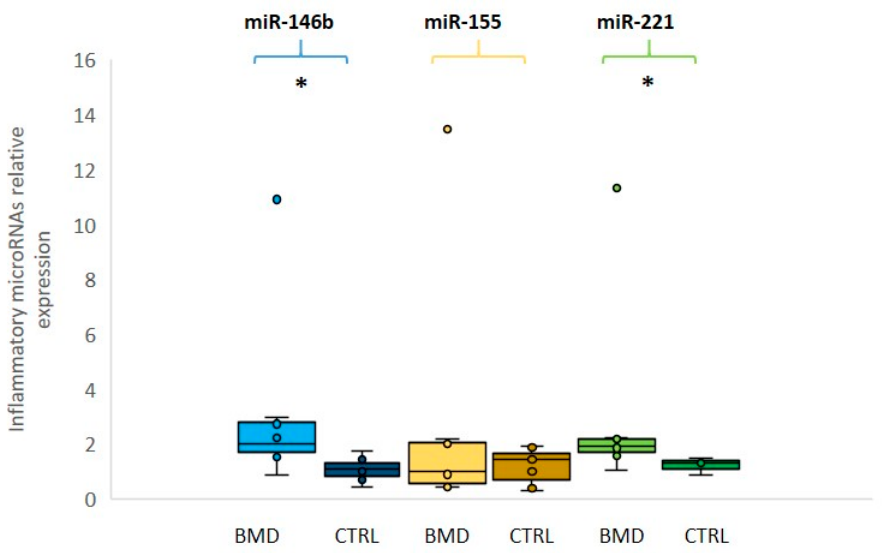
Figure 2. Relative expression of inflammatory microRNAs in BMD patients. Box plots showing the levels of miR-146b (light blue for patients and dark blue for controls), miR-155 (yellow for patients and dark yellow for controls) and miR-221 (green for patients and dark green for controls) (by qRT- PCR analyses in the serum of eight BMD patients and in six healthy controls). Data were significant, p -values ( p ≤ 0.05), for miR-221 and miR-146b between patients and controls. Single points show the individual inflammatory miRNAs levels, the box represents the quartiles (first and third) divided into two parts by the median (second quartile), and the maximum and minimum values are also indicated BMD: Becker muscular dystrophy; CTRL: controls; * indicates significance ( p ≤ 0.05).